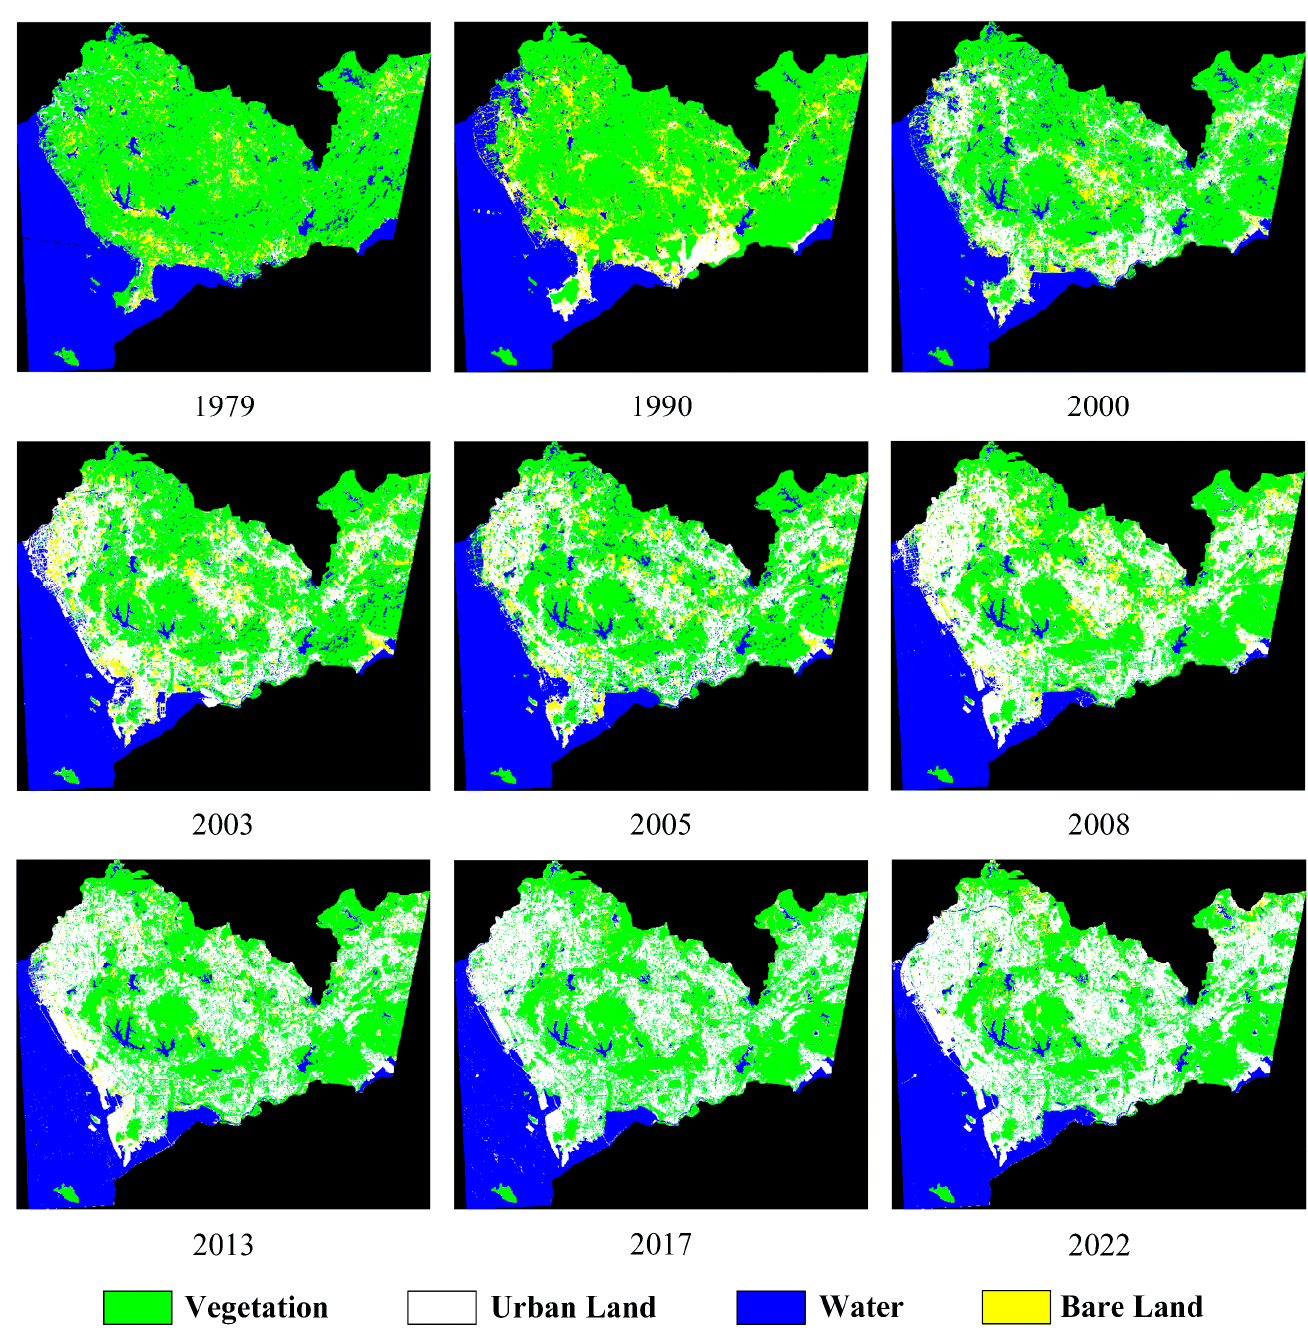
Figure 3. The land cover maps in Shenzhen from 1979 to 2022.